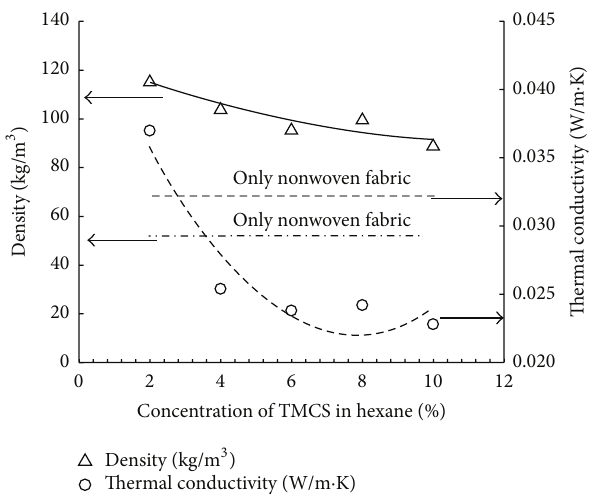
Figure 3: Density and thermal conductivity of the aerogel blankets.